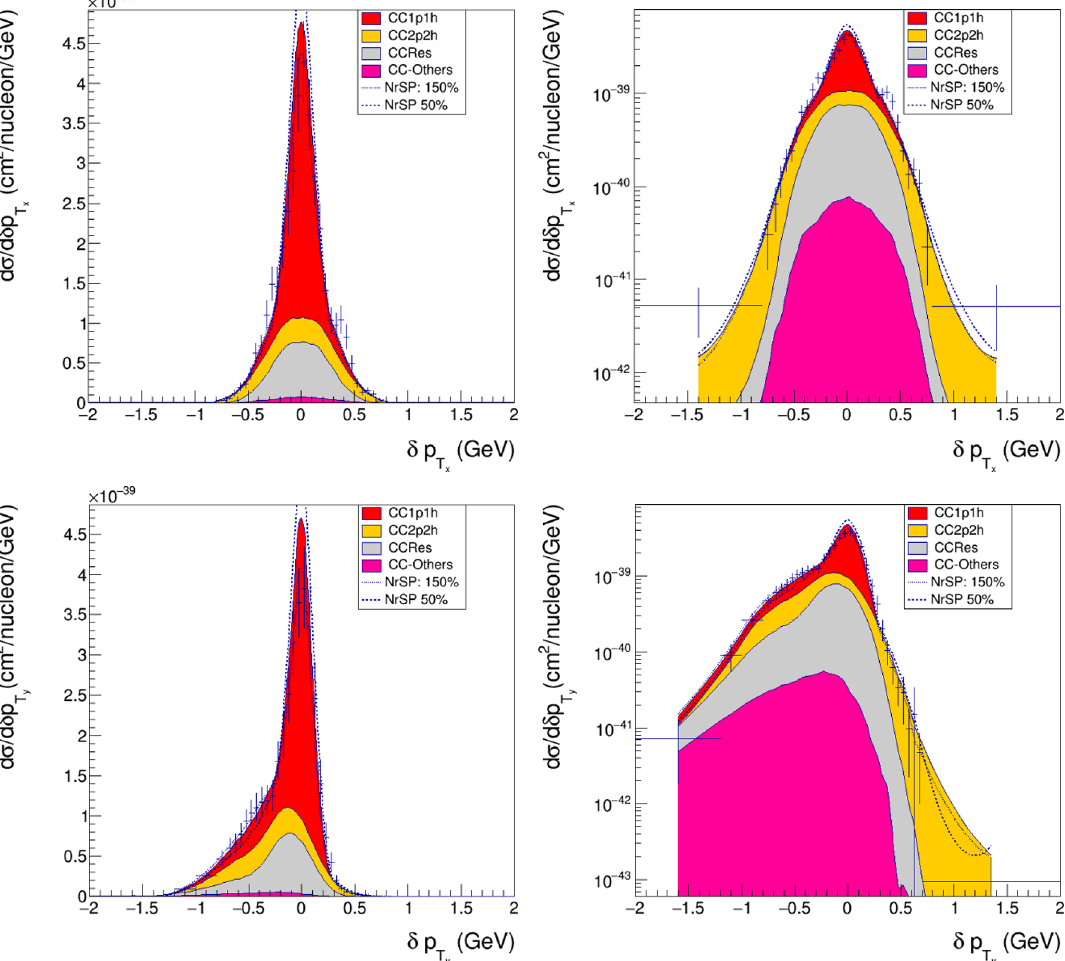
(top) and δp (bottom) distributions [15, 19, 20]. Left and right T y x